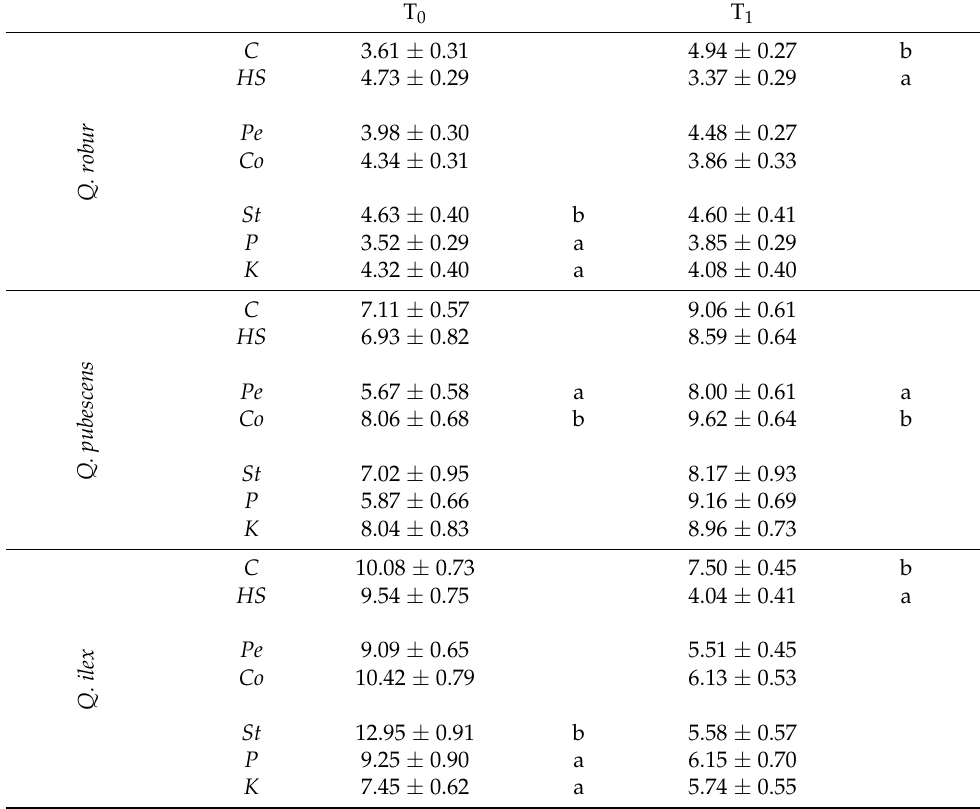
Table 4. Multifactorial ANOVA test results for performance index PI ABS (mean ± SE) at T 0 and T 1 . Lowercase letters indicate homogeneous groups ( p ≤ 0.05 ). Levels: C , HS : control and high water stress; Pe , Co : peat and coir substrate; St , P , K : standard, P- and K-enriched fertilization. T 0 T